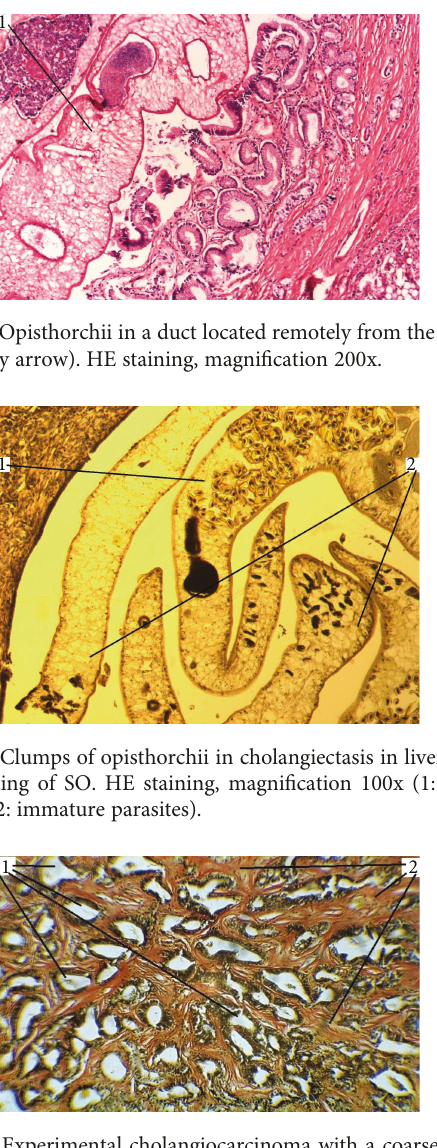
Figure 5: Experimental cholangiocarcinoma with a coarse stroma in the setting of SO. Van Gieson ’ s staining, light microscopy magni fi cation 20x (1: tumour glandular complexes; 2: coarse stroma).